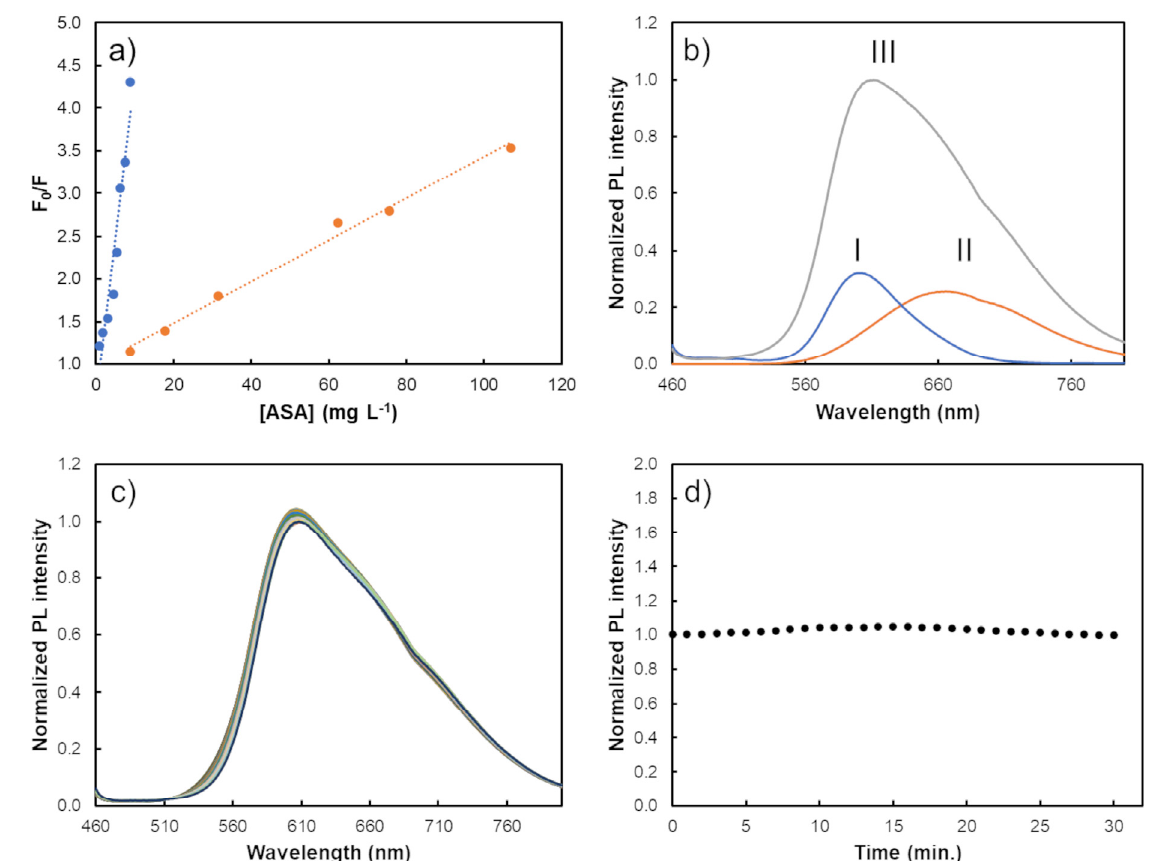
Figure 7. ( a ) Stern–Volmer plots displaying the ratio of the emission intensities for MPA-AIS (orange circles) and MES-CdTe (blue circles) when interacting with increasing concentrations of aspirin. ( b ) PL spectra of (I) MES-CdTe QDs, (II) MPA-AIS QDs and (III) MES-CdTe/MPA-AIS combined probe. ( c ) PL spectra evolution of MES-CdTe/MPA-AIS combined probe and ( d ) the corresponding evolution of the maximum PL intensity during 30